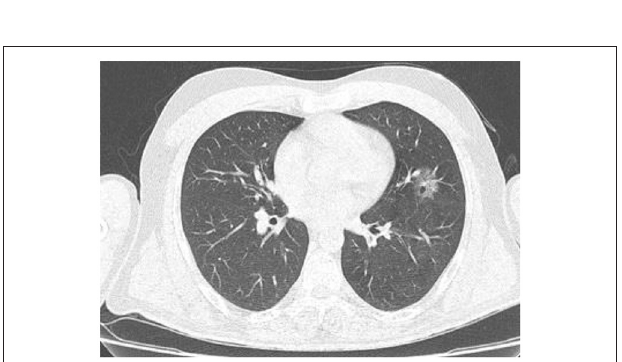
FIGURE 3 | High resolution, axial non-enhanced spiral chest CT images (lung window) of a 50-years old patient who was confirmed to be infected by COVID-19 and admitted to hospital with fever and dry cough. CT images show several airspace opacities, ground-glass shadows, and multiple sub-segmental consolidations most pronounced in the lower lobe of both lungs.